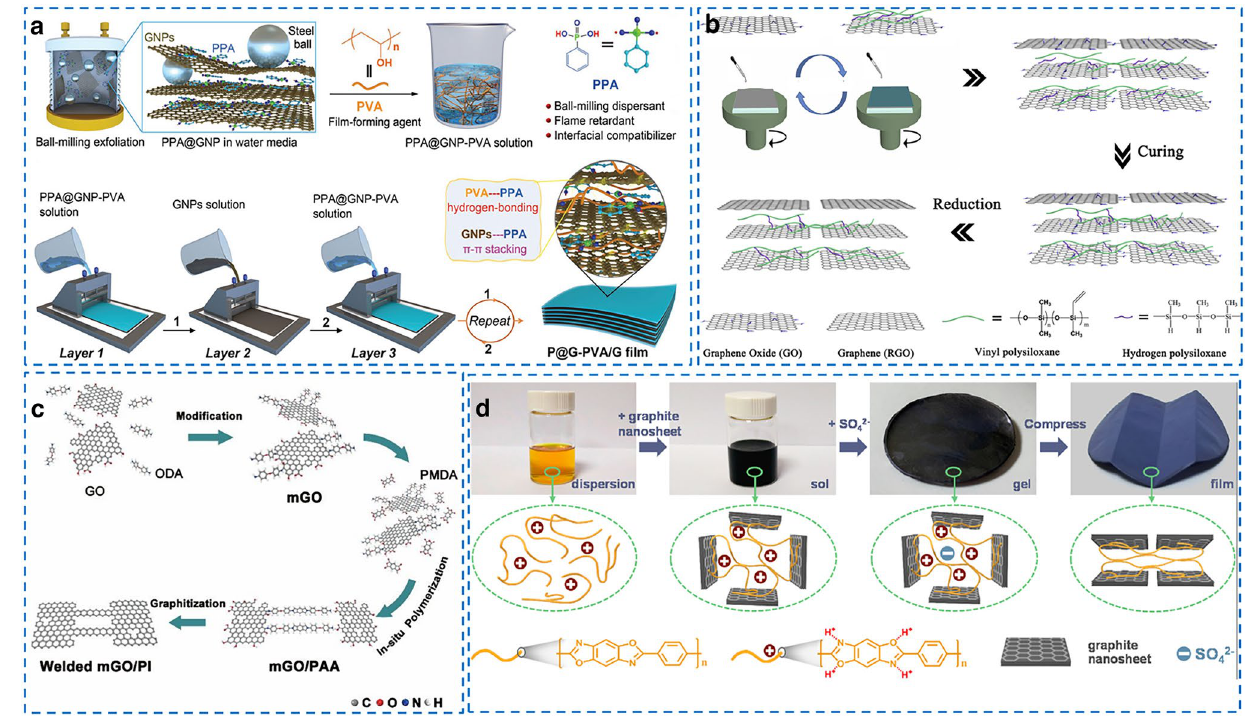
Fig. 8 Fabrication of thermally conductive carbon/polymer composite films with high in‑plane k . a Fabrication of PPA@GNPs/PVA films using LBL assembly approach. Reproduced with permission from Ref. [115]. Copyright 2021, Wiley–VCH. b Fabrication of silicone rubber/RGO films using spin‑assisted LBL assembly method Reproduced with permission from Ref. [116]. Copyright 2018, Elsevier. c Fabrication of RGO/ PI films using “modified welding” method. Reproduced with permission from Ref. [125]. Copyright 2019, American Physical Society. d Fabri‑ cation of poly(p‑phenylene‑2,6‑benzobisoxazole) nanofiber/graphite film using a sol–gel film transformation approach. Reproduced with permis‑ sion from Ref. [127]. Copyright 2021,